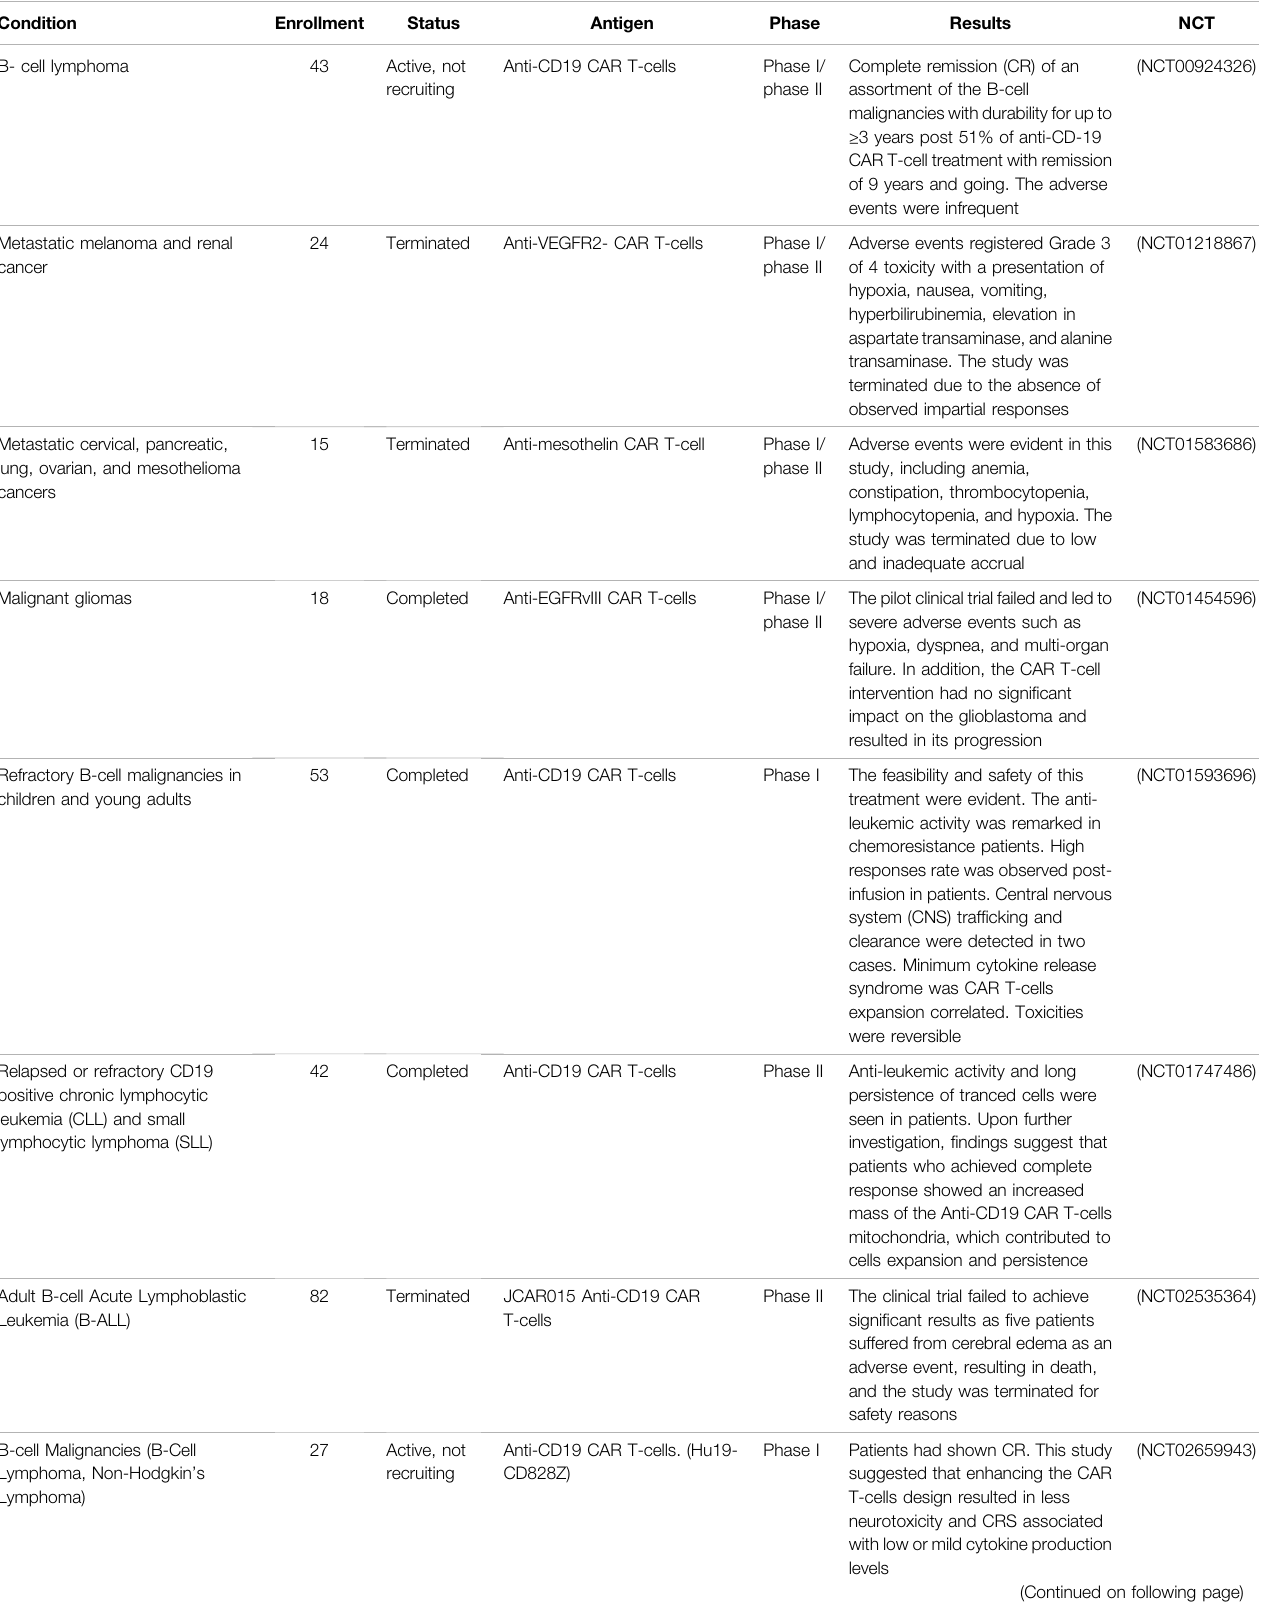
TABLE 1 | CAR T-cell clinical trials with recorded results from